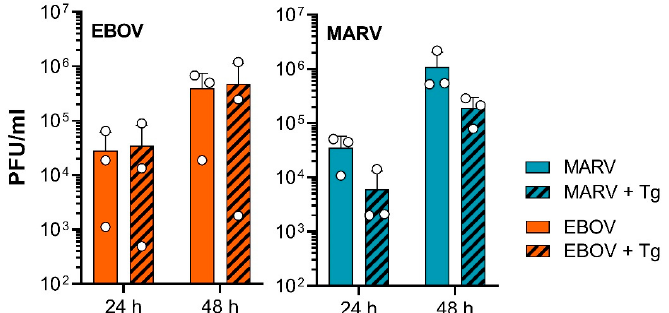
Figure 1. UPR activation by Tg does affect EBOV and MARV differently. HuH7 cells were infected with MARV or EBOV at a MOI of 0.01. Immediately after infection, the respective cells were treated with 5 nM Tg or with the solvent DMSO. Supernatants were collected at the indicated times after infection and analyzed for infectious virus by plaque titration.